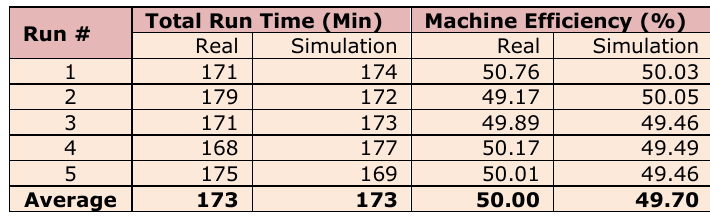
Table 5. Comparative results from real system and simulation